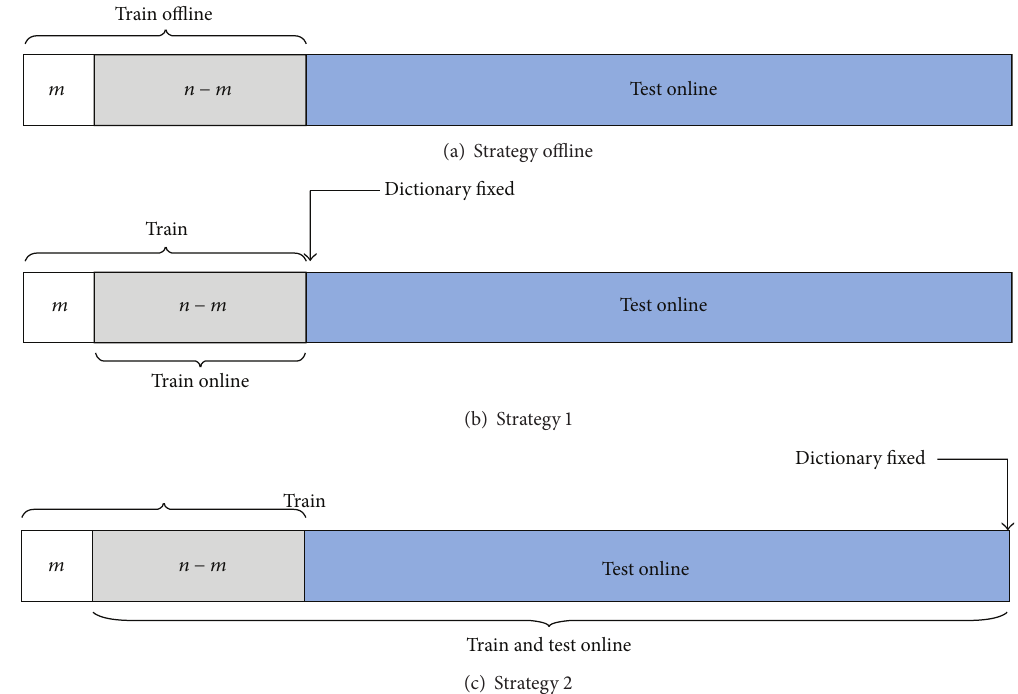
Figure 3: Offline and two online abnormal event detection strategies based on one-class SVM. (a) Strategy offline. The training data are learnt as one batch offline. (b) Strategy 1. The dictionary is fixed when all the training data are learnt. (c) Strategy 2. The dictionary continues being updated through the testing period.